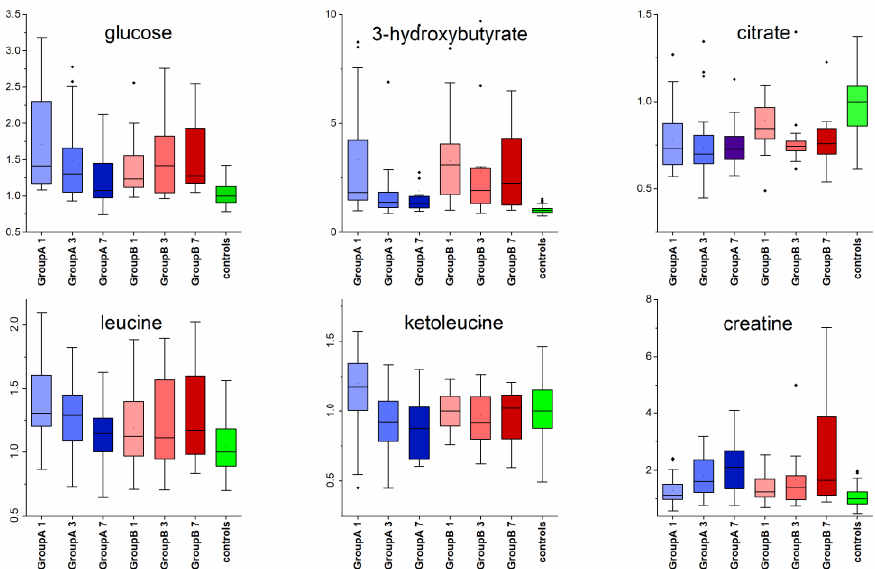
Figure 3. Relative concentrations of selected metabolites in blood plasma for patient Groups A and B on Day 1, Day 3, and Day 7. Values are relativised to the median of controls set to 1.